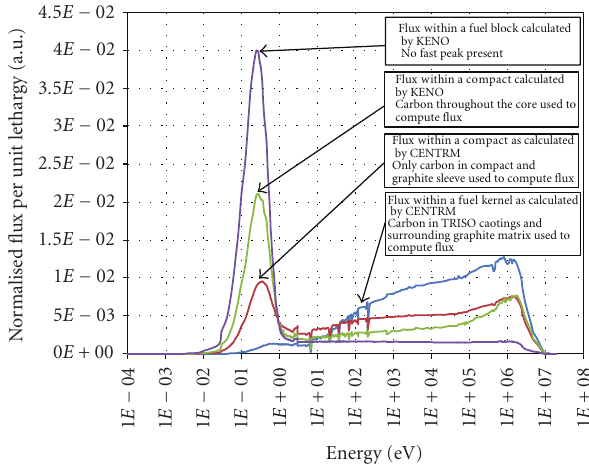
Figure 2: Fluxes in VHTRs at di ff erent levels of the double heterogeneity treatment.